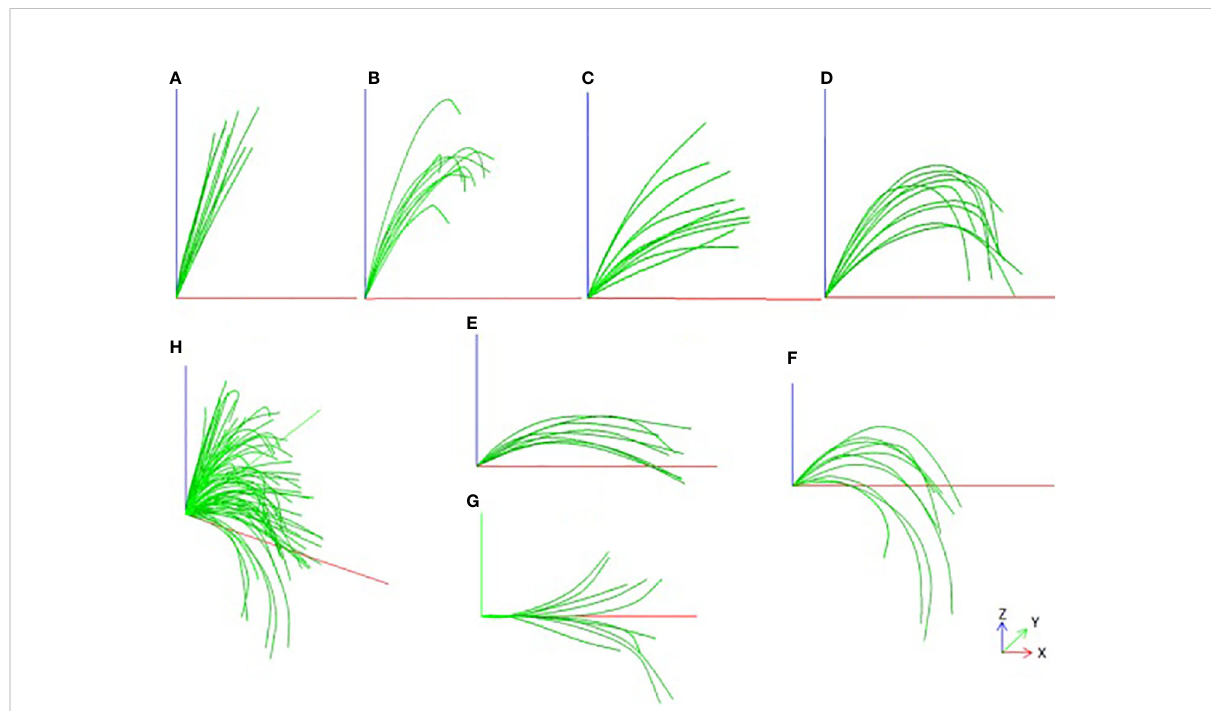
FIGURE 5 Smooth visualization effect of leaf midrib curve and Classi fi cation, (A) Vertical type, (B) Tip curved type, (C) Stretch type, (D) Bending type, (E) Creeping type, (F) Drooping type, (G) De fl ection type, (H) All